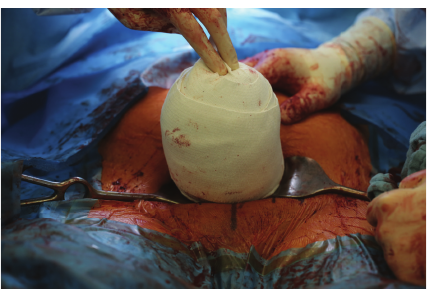
Figure 2: Wrapped uterus in case 3